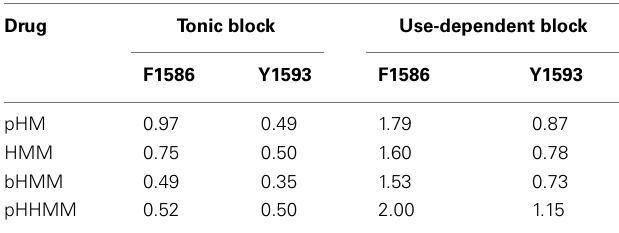
FIGURE 7 | Mutant cycle analysis of mexiletine and pHM binding to the wild-type hNav1.4 channel and its mutantsY1593C and F1586C. Mutant cycle analysis for tonic block considers IC 50 values calculated at 0.1Hz stimulation frequency (A) , while IC 50 calculated at 10Hz stimulation frequency allowed mutant cycle analysis for use-dependent block (B) .The Xi and Yi values represent the changes in affinity with each mutation, calculated as the ratio of IC 50 values.The coupling constant Ω is calculated as the X 1 to X 2 ratio and the coupling energy Δ G is calculated as RT ·ln Ω , where R is the perfect gas constant (8.314JKmol − 1 ) and T the temperature expressed in Kelvin (295.15K = 22˚C).The calculated Δ G shown in red was converted to kilocalorie per mole. Table 3 | Coupling energy ( Δ G , kcal/mol) calculated from mutant cycles, as shown in Figure